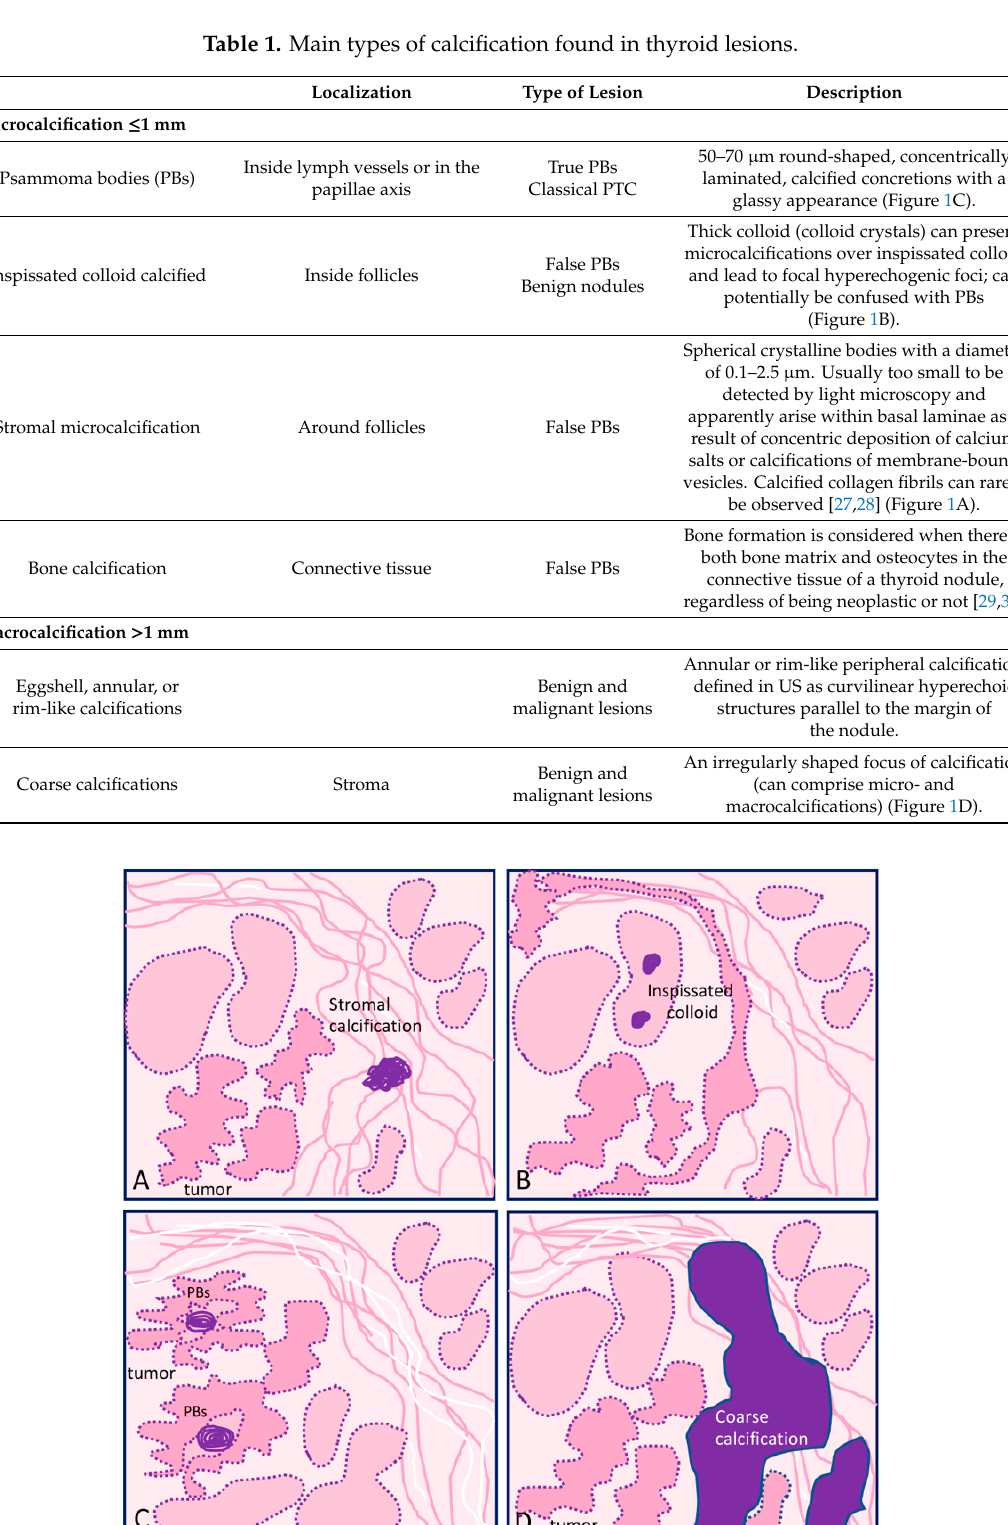
Table 1. Main types of calcification found in thyroid lesions.